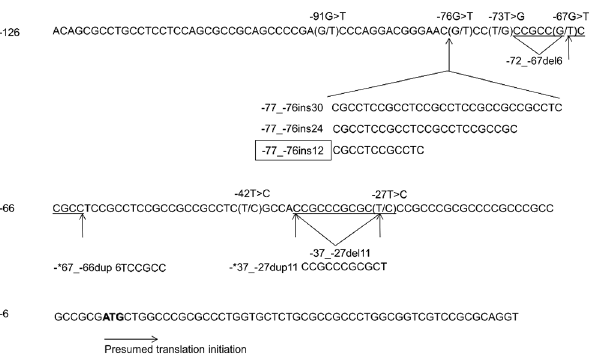
Fig 1. DNA sequence variants identified within the 5 ’ UTR of the Cox-2 gene in 152 dogs. Base positions upstream of the ATG translation initiation site (position zero) are noted on the left. * The exact base position for the duplicated sequence could not be determined. The sequence variant most commonly found in gray wolves is boxed.